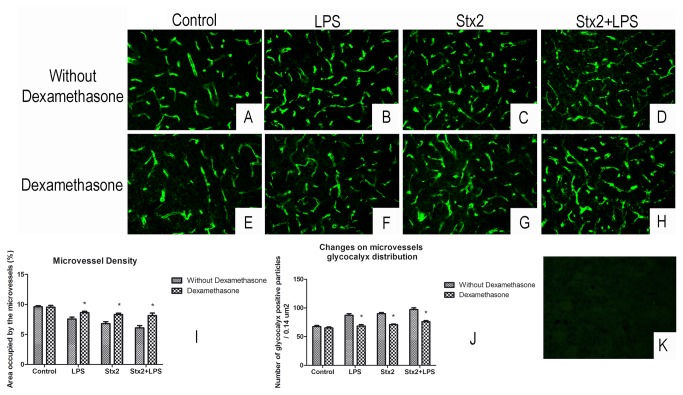
Dexamethasone maintains microvessel integrity.Fluorescence micrographs show changes in the profile of microvessels from the motor cortex after four days of treatment with saline (A and E), LPS (B and F), Stx2 (C and G) and Stx2+LPS (D and H) followed by i.p. injection of saline (A through D) or Dexamethasone (E through H). Dexamethasone rescues microvessel density (I) and glycocalyx distribution (J), similar to density and distribution in the control groups. K: negative control in mice motor cortex obtained by not adding

Lycopersicum

esculentum
 lectins. *: significant differences between Dexamethasone and saline treatments.